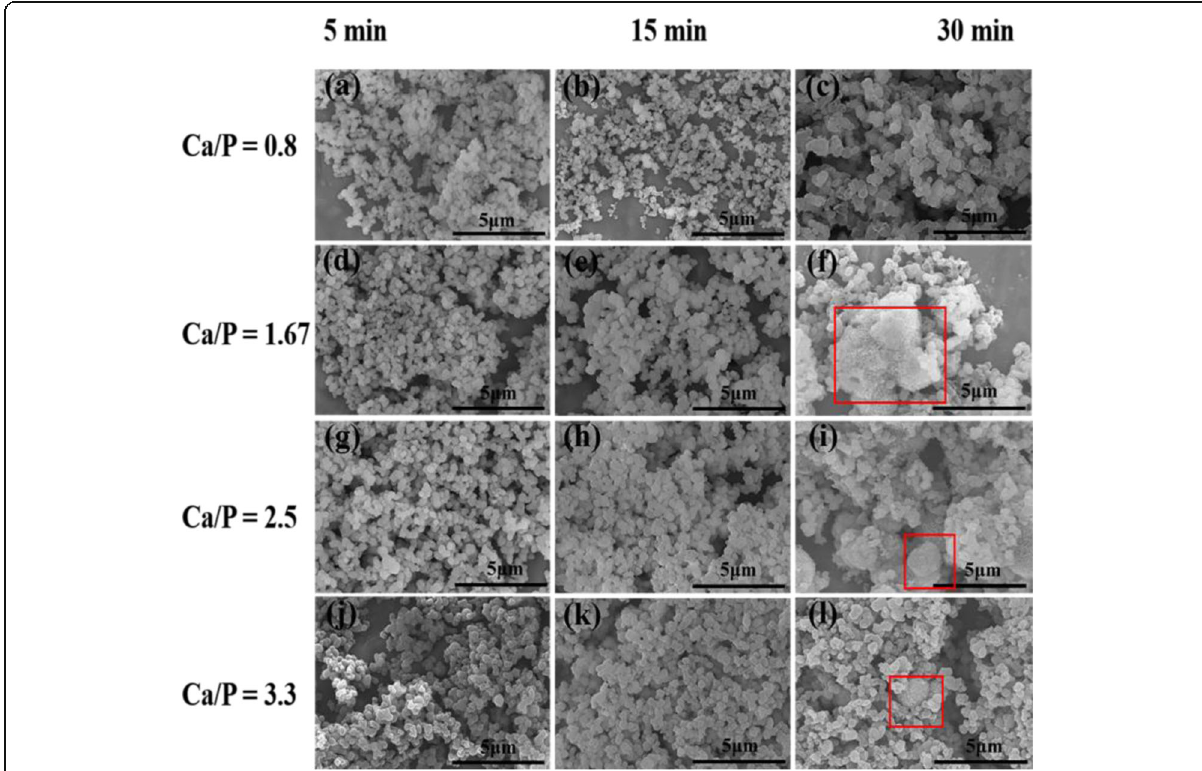
Fig. 1 SEM images of ATP-CG microspheres prepared by microwave hydrothermal method at 120 °C